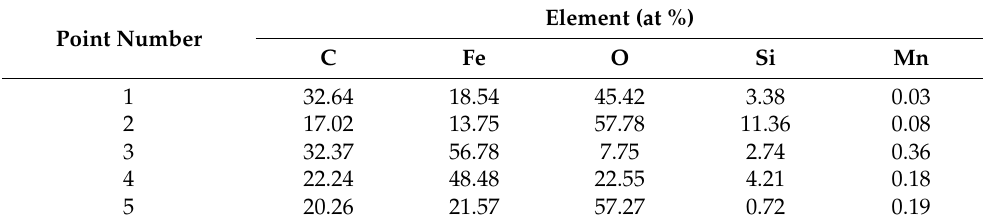
Table 1. Results of EDS analysis at different positions according to Figure 10c,d. Point